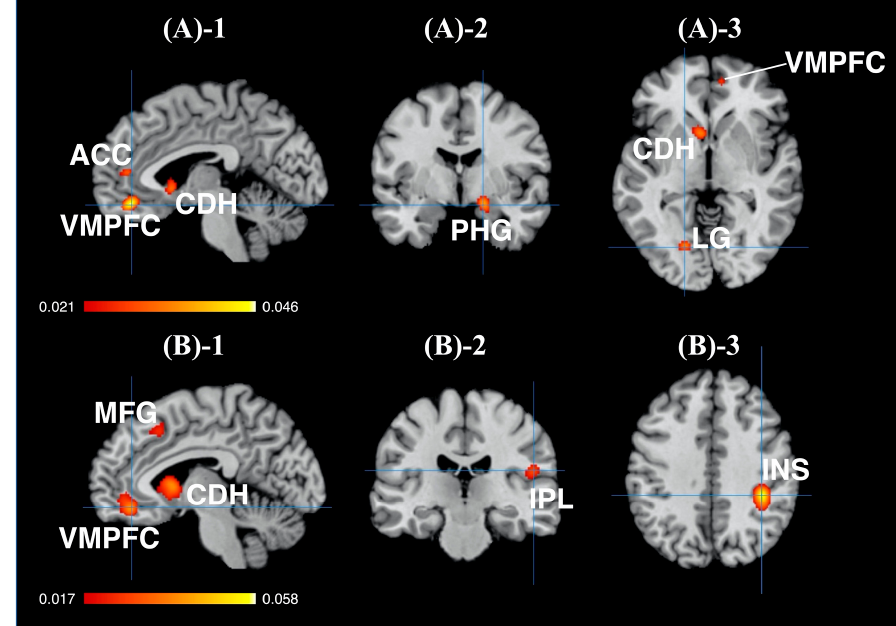
Figure 4. Results of ALE (A)-1 sagittal view of brand equity-related brain regions, crosshair = ( − 4, 42, − 16); (A)-2 coronal view of brand equity-related brain regions, crosshair = (18, − 4, 16); (A)-3 axial view of brand equity-related brain regions, crosshair = ( − 18, − 74, − 4); (B)-1 sagittal view of unbranded object-related brain regions, crosshair = ( − 6, 40, − 14); (B)-2 coronal view of unbranded object-related brain regions, crosshair = (38, − 36, 38); (B)-3 axial view of unbranded object-related brain regions, crosshair = (52, − 24, 18). Abbreviations: ALE: activation likelihood estimation; ACC: anterior cingulate cortex; VMPFC: ventromedial prefrontal cortex; CDH: caudate head; PHG: parahippocampal gyrus; LG: lingual gyrus; MFG: middle frontal gyrus; IPL: inferior parietal lobule; INS: